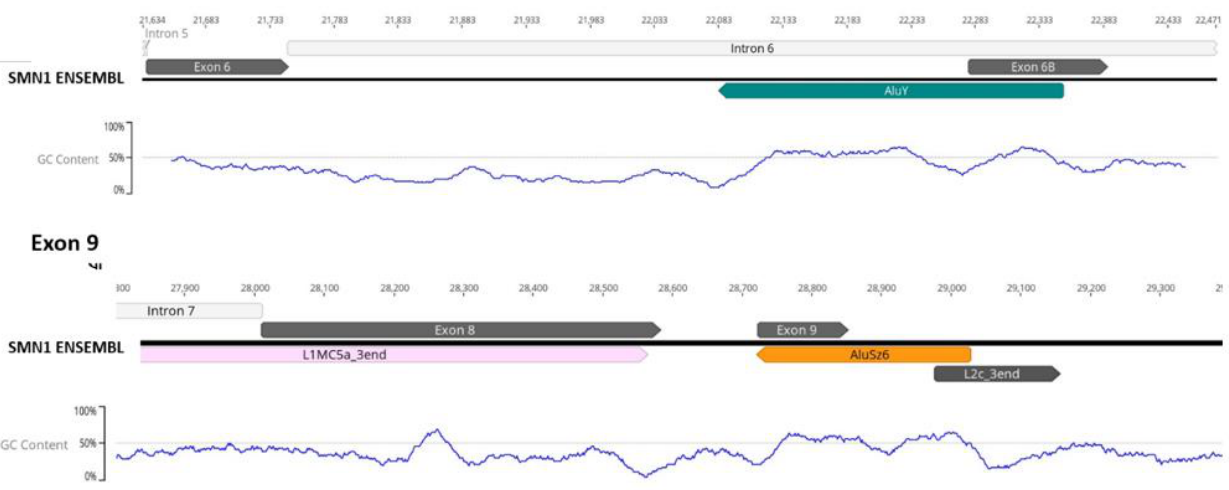
Figure 8. Identification of SMN1 / 2 alternative exonization events. On top, exonization event of an intronic antisense Alu repeat (represented by a green arrow) that gave birth to alternative exon 6B. Below, another exonization event of an antisense Alu element (represented by an orange arrow) that resulted in the formation of SMN1 / 2 alternative exon 9. G + C content analysis of both regions shows a higher G + C content in the exonization regions when compared with the surrounding areas, which might have favored Alu insertions and the posterior exonization events.